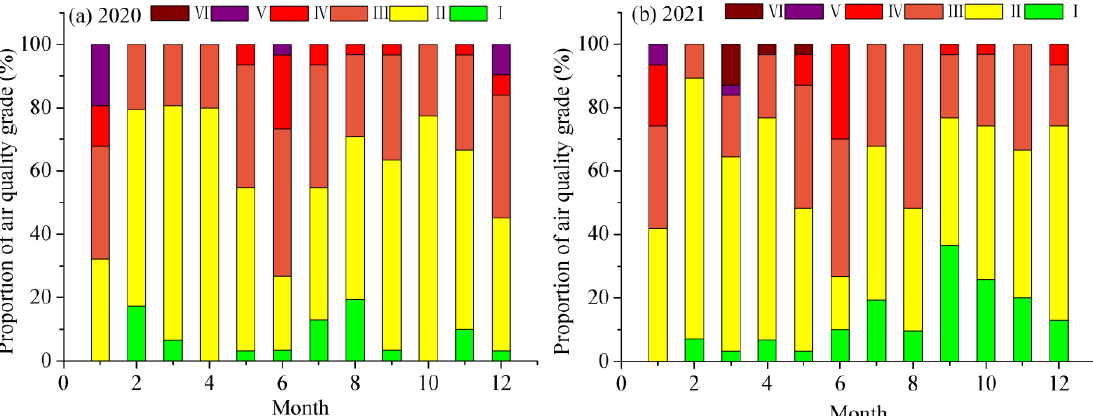
Figure 4. Monthly variations in the proportions of air quality ranks in Jinan City in 2020 and 2021. ( a ) monthly changes of the proportions of AQI ranks in 2020; ( b ) monthly changes of the proportions of AQI ranks in 2021.